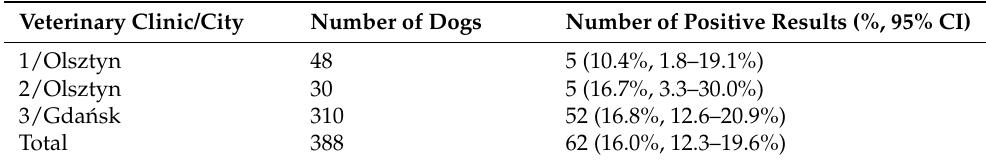
Table 2. Number of investigated canine samples and percentage of dogs positive for SARS-CoV-2 antibodies by ELISA and iIFA in total and from individual clinics participating in this study. Veterinary Clinic/City Number of Dogs Number of Positive Results (%, 95% CI)